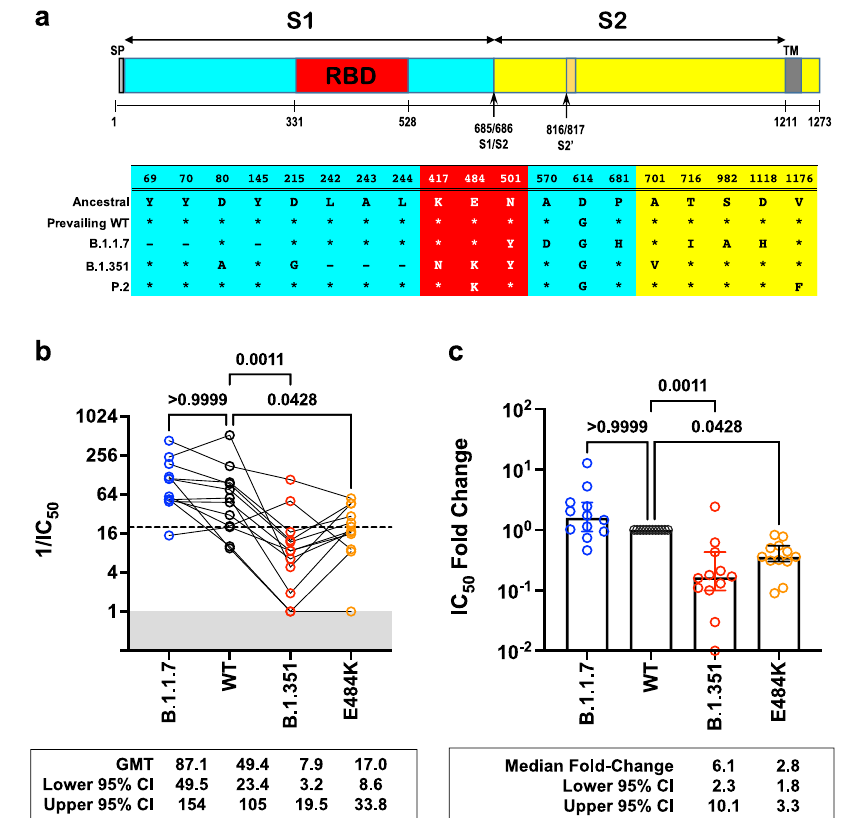
Fig. 2 Neutralization activity of antibody responses elicited by the Sputnik V vaccine. a Schematic of the Spike substitutions that make up the variants being evaluated in this study. The amino acid positions and corresponding “ Ancestral ” sequence of the Wuhan isolate is shown. The prevailing WT sequence now has a D614G substitution. All the variants and mutants have D614G. ( b ) Neutralization activity of individual serum samples against rcVSV- CoV2-S with the WT (black circles), B.1.1.7 (blue circles), B.1.351 (red circles), or E484K (orange circles) spike proteins. Neutralization is represented by the reciprocal 50% inhibitory dilution factor (1/IC 50 ). Sera samples with no appreciable neutralization against a given virus were assigned a de fi ned 1/IC 50 value of 1.0, as values ≤ 1 are not physiological (Gray shaded area). Dashed line indicates the lowest serum dilution tested (1/IC50 = 20). Geometric mean titers (GMT) and 95% CI for the neutralizing activity of all vaccine sera are indicated below each of the viral spike proteins examined. Adjusted p -values are indicated (non-parametric Friedman test with Dunn ’ s multiple comparisons test). c For each serum sample, the fold-change in IC 50 (reciprocal inhibitory dilution factor) against the indicated variant and mutant spike proteins relative to its IC 50 against wild-type (WT) spike (set at 1) is plotted. Adjusted p - values were calculated as in b . Medians are represented by the bars and whiskers demarcate the 95% CI. Neutralization dose – response curves were performed in triplicates, and the mean values from each triplicate experiment are shown as the single data points for each sera sample. Source data are provided as a Source Data fi